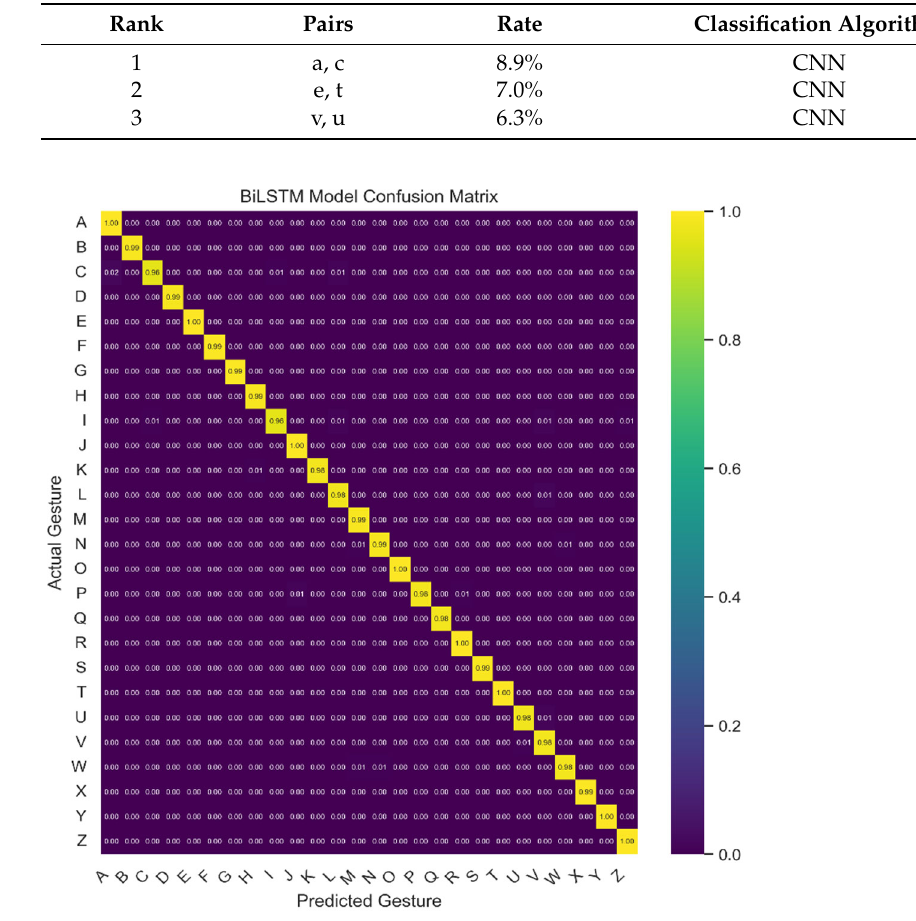
Figure 11. Confusion matrix generated using the LSTM algorithm.